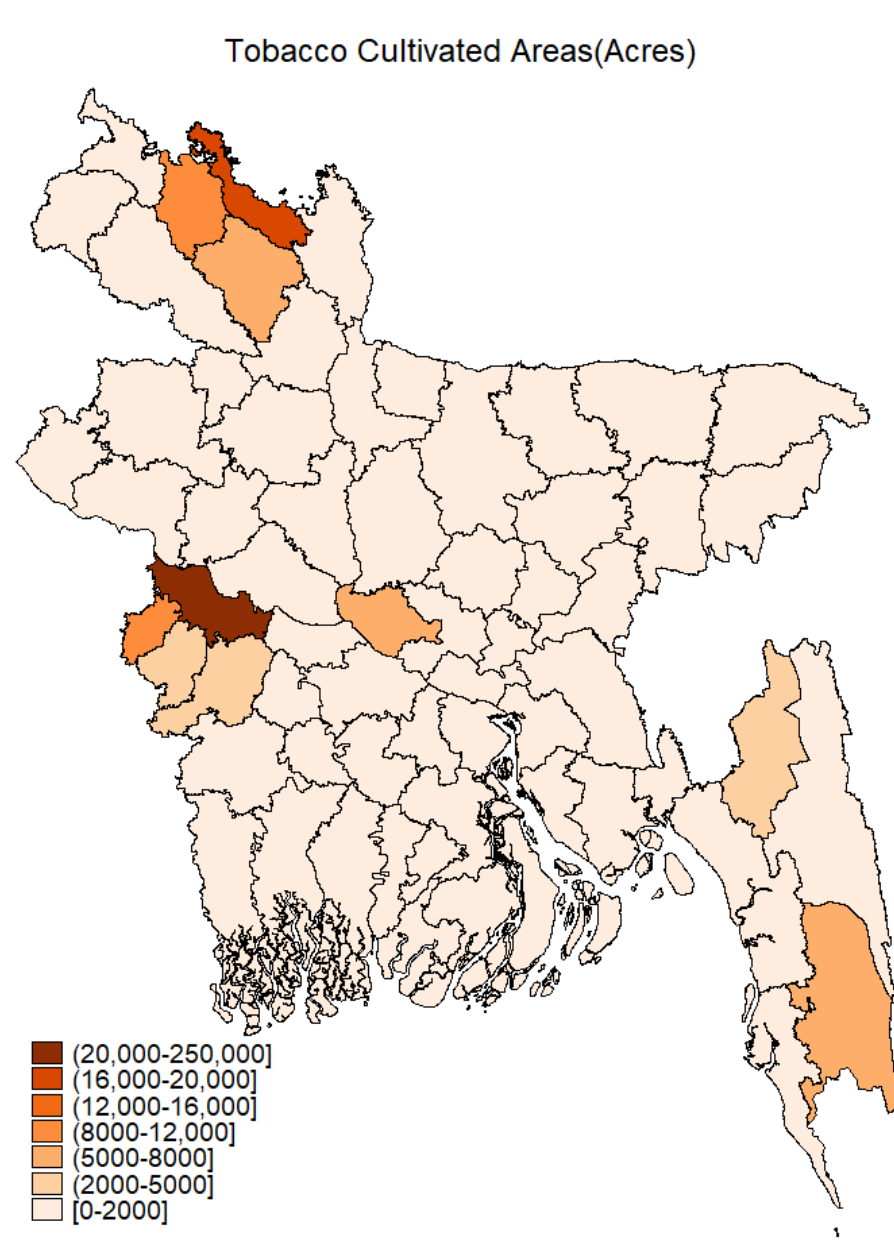
Figure A1. Areas with tobacco cultivation (acres): 2017–2018. Source: Agricultural Yearbook, BBS (2018).